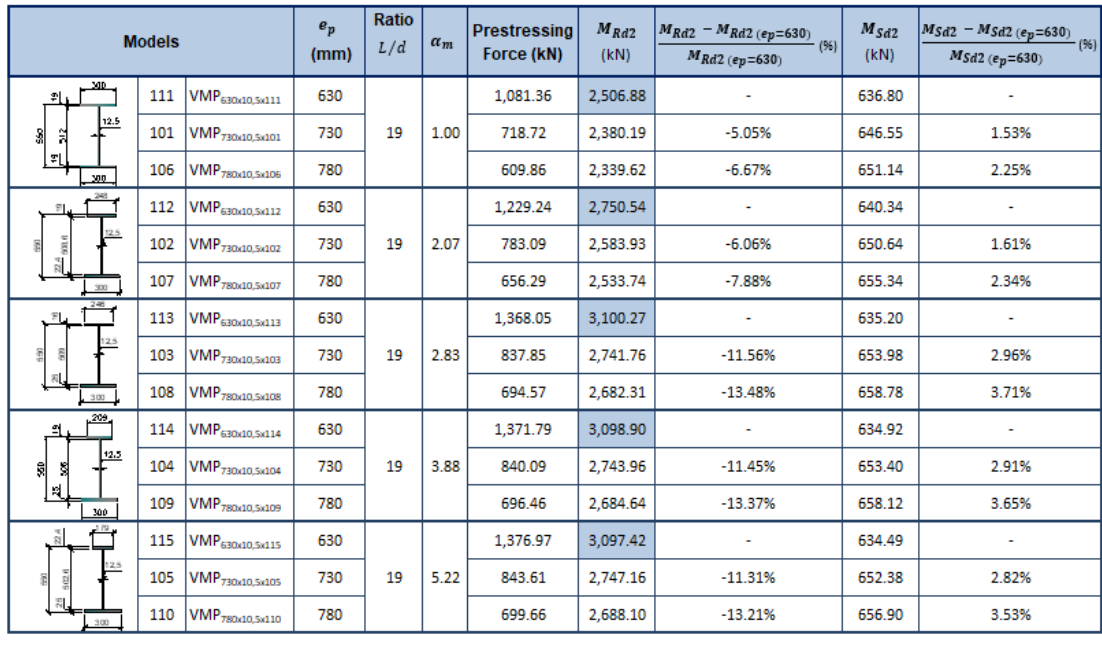
Figure 10. Eccentricity influence - / L d ratio =